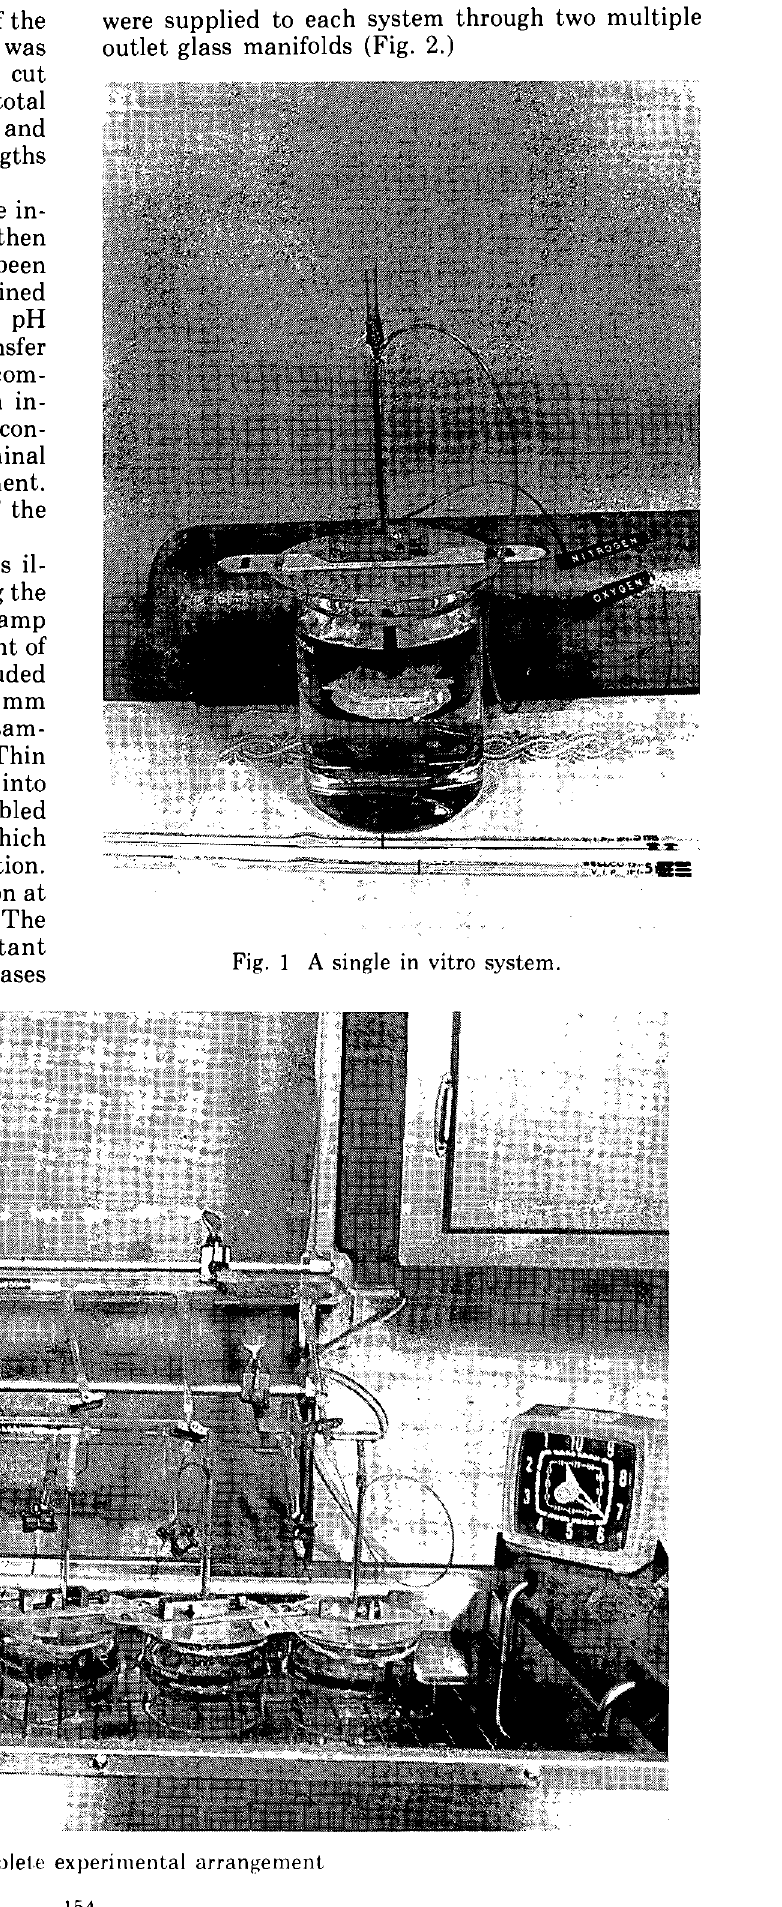
Fig. 2. The complet.e experimental